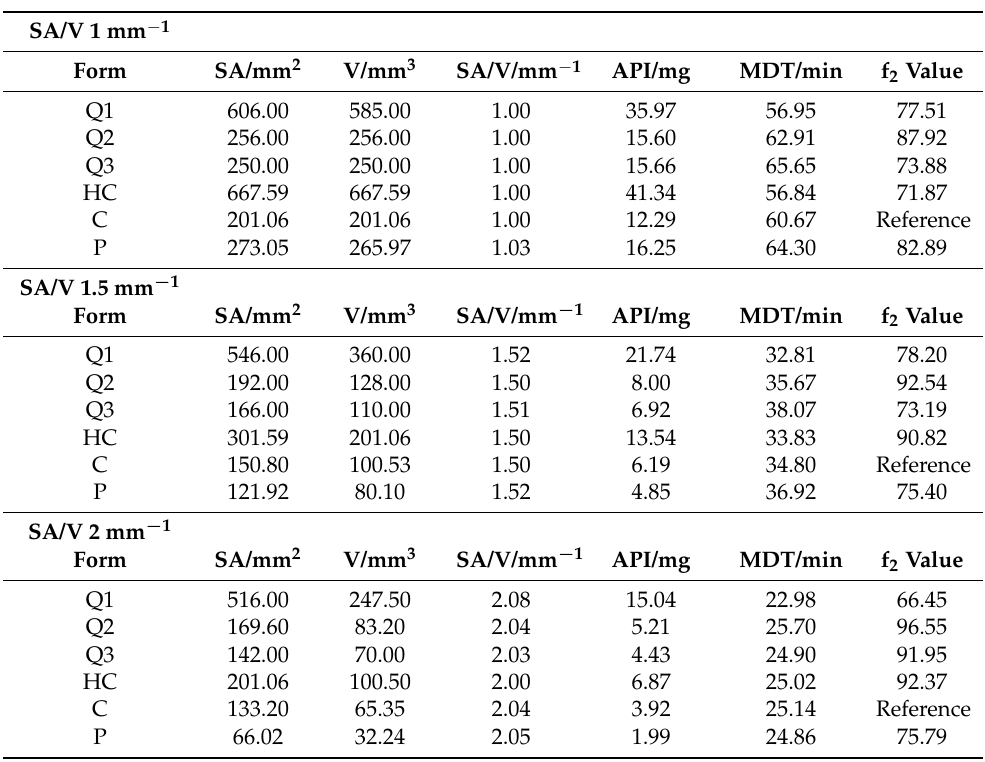
Table 3. Characteristics of the printed geometries including the calculated MDT of the PVA- PDM